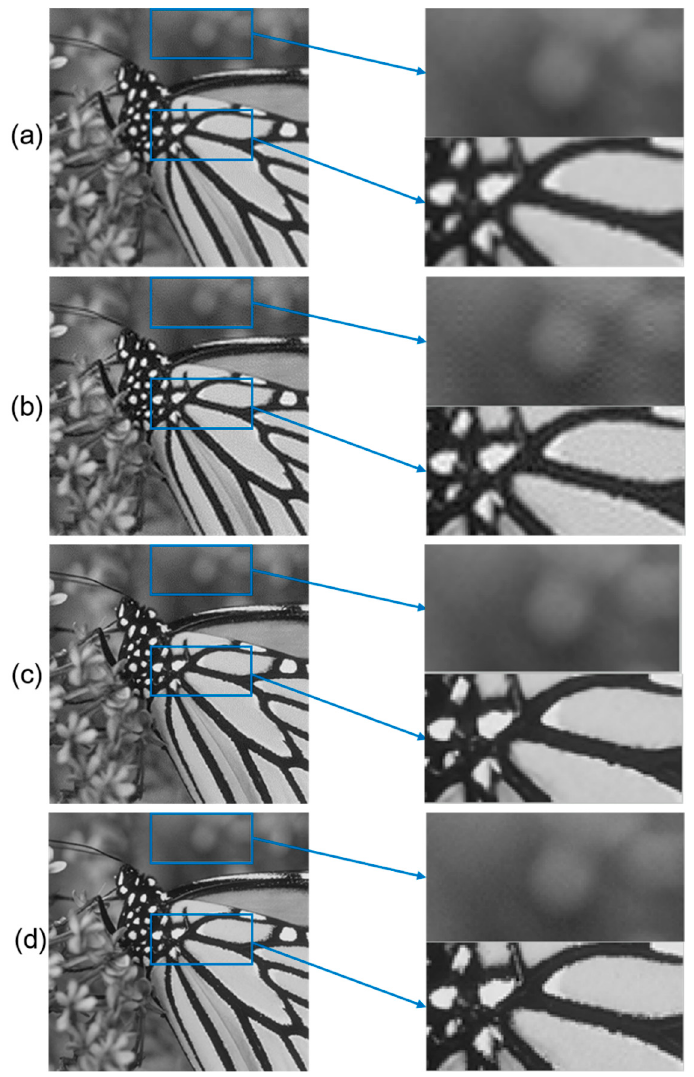
Figure 1. Illustration of fixed pattern noise in CS method when upscaling factor is set 2 for demonstration. Subfigure ( a ) is the output of bicubic SR method; subfigure ( b ) is the output of CS; subfigure ( c ) is the reconstructed output of CNN; subfigure ( d ) is the original HR image. The corresponding zoomed pictures are placed on the right. The PSNR and SSIM of CS are 28.86 dB and 0.8950. The PSNR and SSIM of bicubic are 28.22 dB and 0.9260. The PSNR and SSIM of CNN are 34.18 dB and 0.9719.